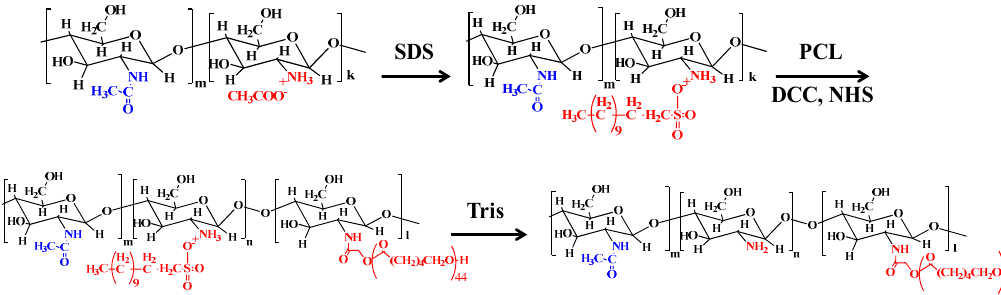
Figure 1. A schematic presentation of the synthetic procedure that was followed for the preparation of the chitosan- graft -poly( ε -caprolactone) (CS- g -PCL) copolymer.